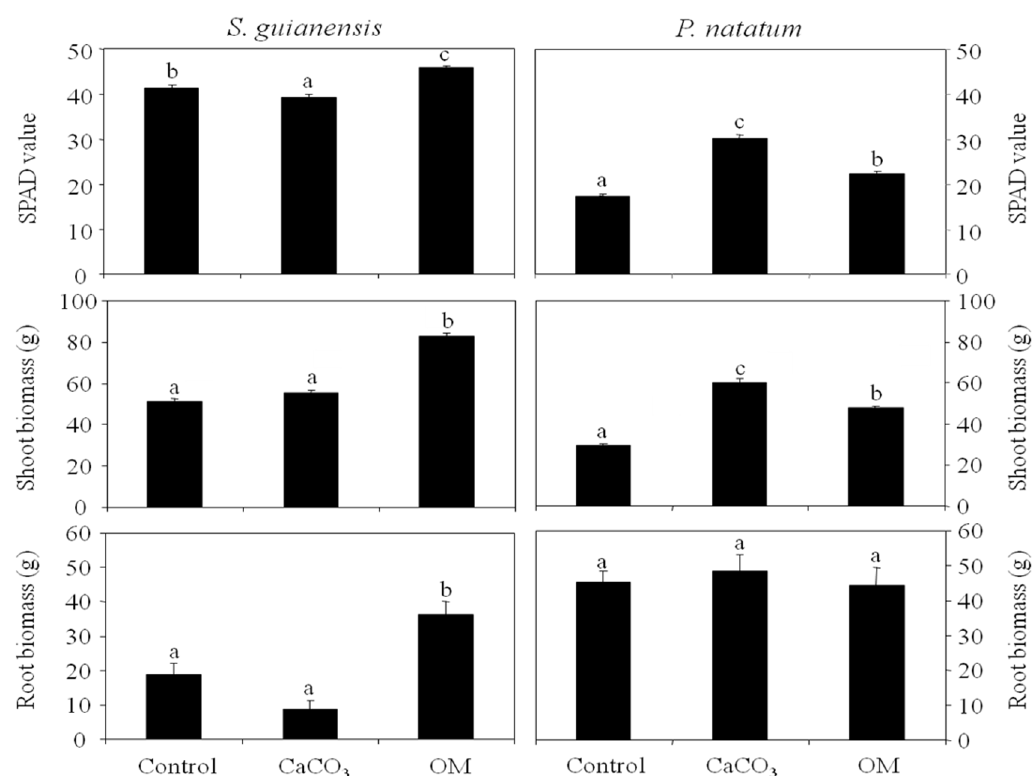
Figure 1. Influences of liming (CaCO 3 ) and plant residue incorporation (OM) on the plant growth of S. guianensis and P. natatum . Averages ( n = 5) followed by the same letter are not significantly different (Tukey’s post hoc test, p = 0.05).